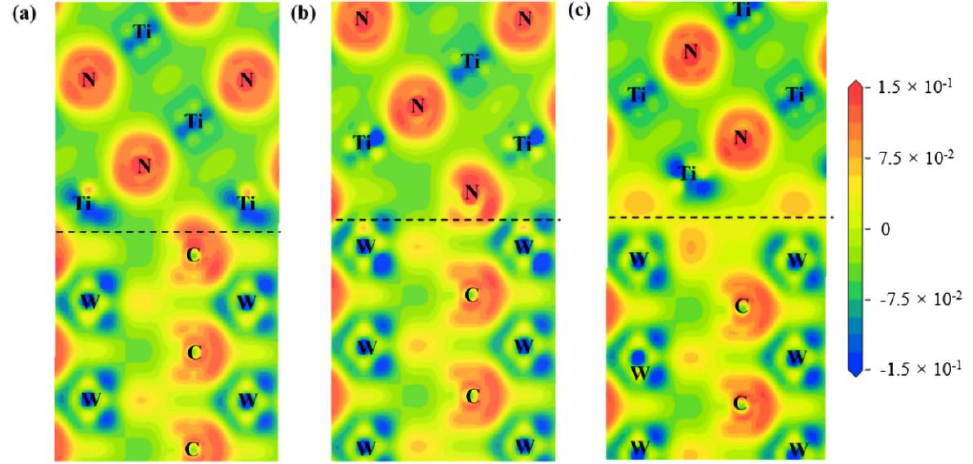
Figure 10. Charge density difference of the (1120) slice of WC(0001)/TiN(111) interfaces. ( a ) C-HCP-Ti, ( b ) W-HCP-N, ( c ) W-Hole-Ti.